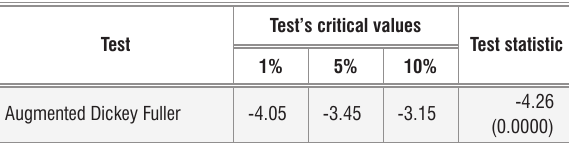
Summary statistics of normality tests of annual rainfall data from 1901 to 2009 N Minimum Maximum Mean